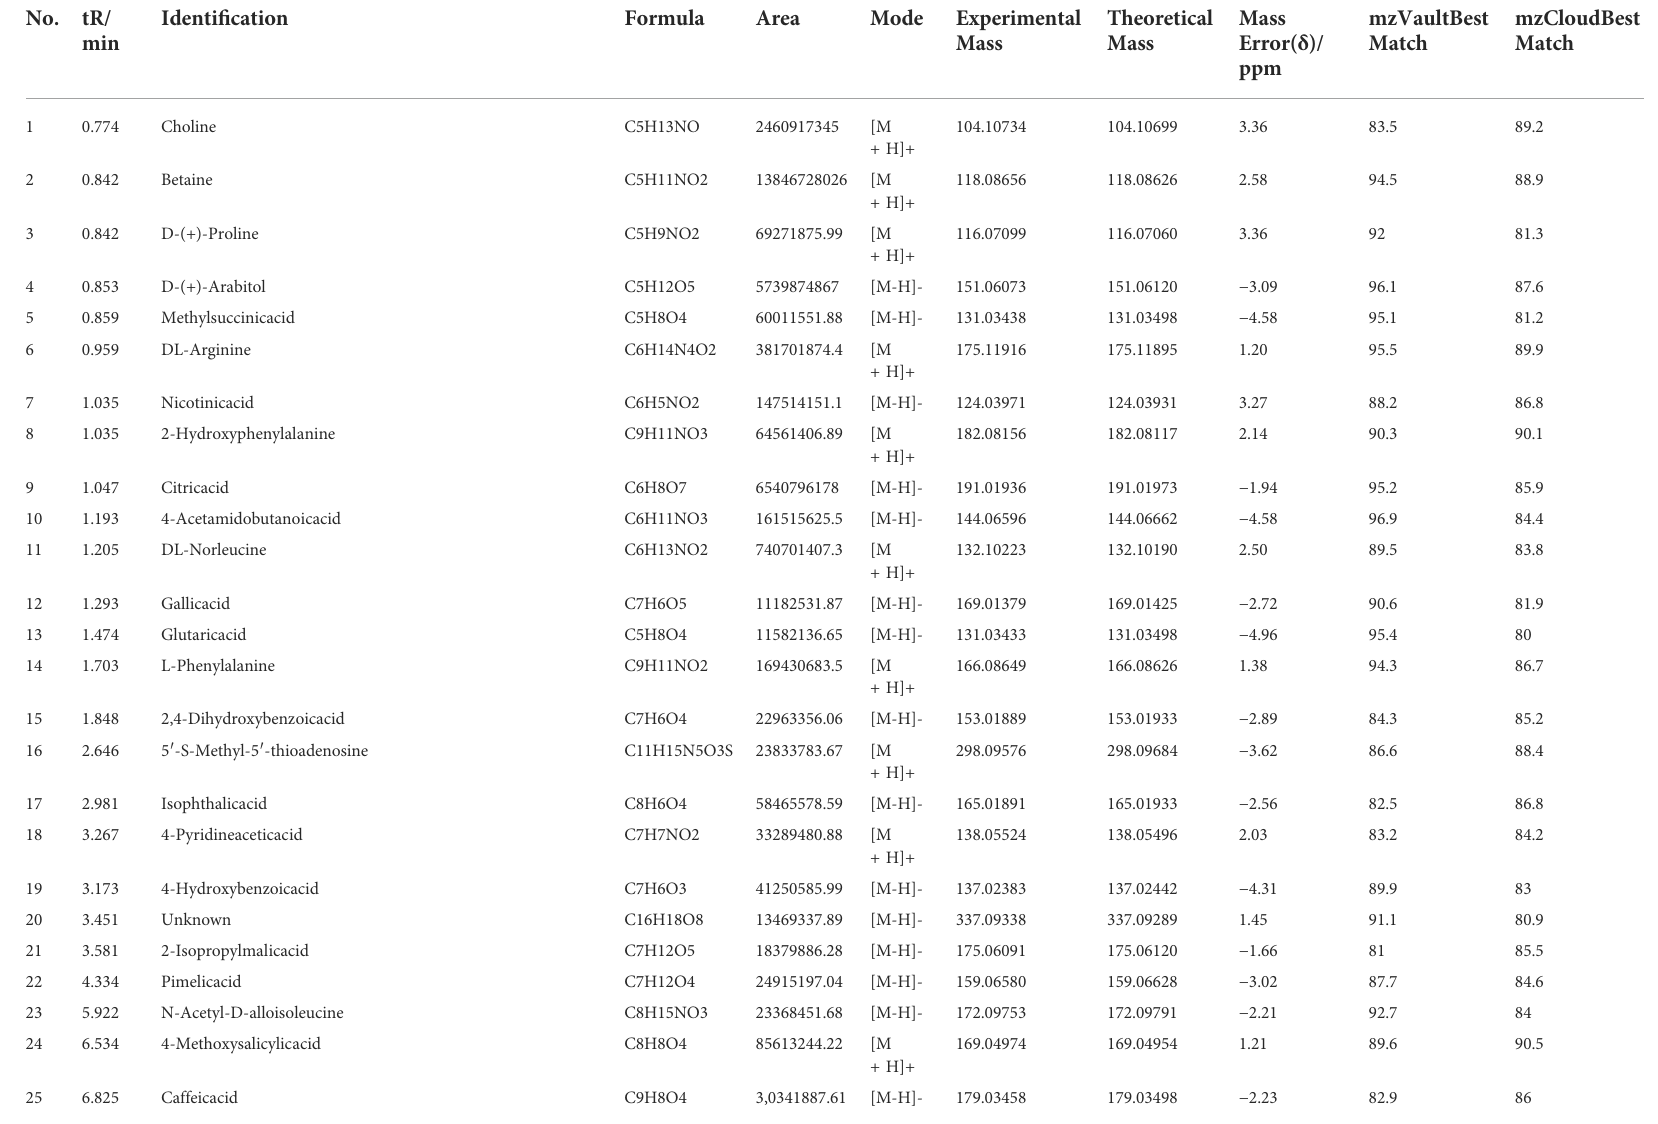
TABLE 1 UPLC-Q-EOMS data of 44 characterized compounds in UEE. No. tR/